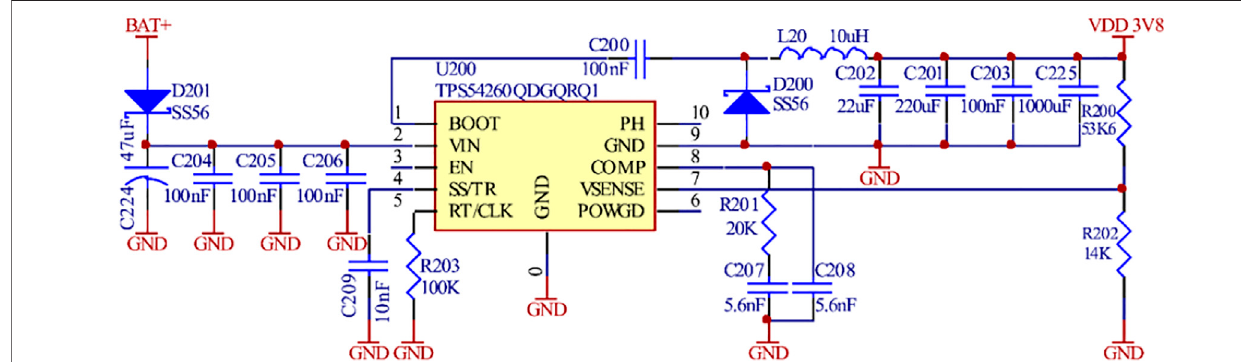
FIGURE 2 | 3.8 V power supply circuit schematic diagram.